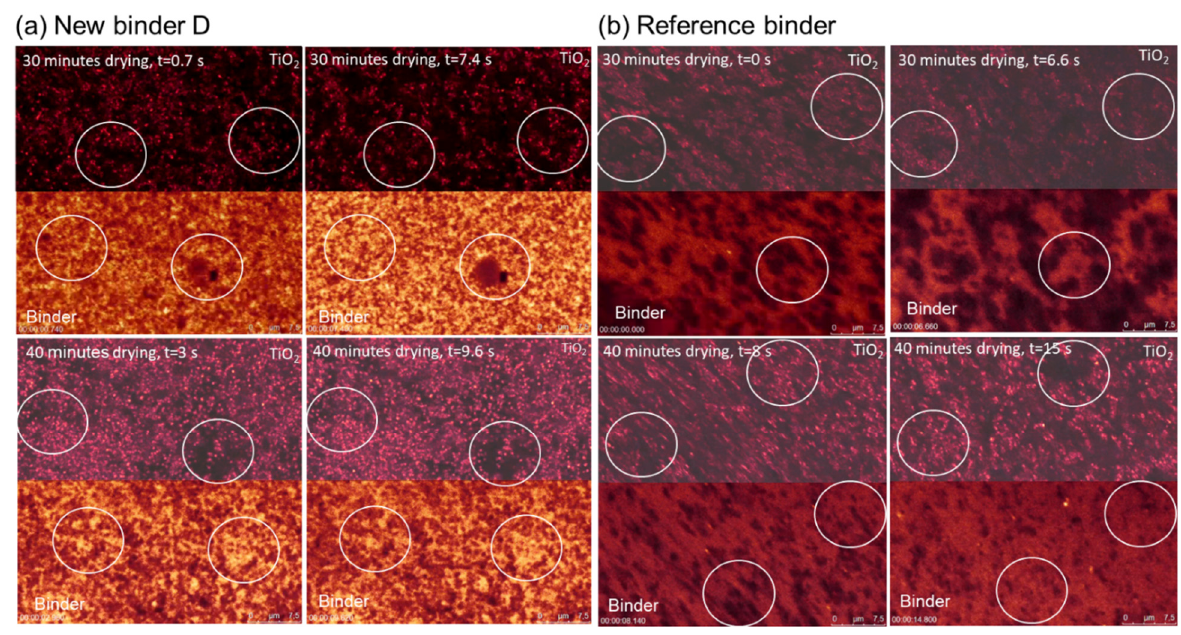
Figure 8. Rewetting kinetics of partially dried paints. If the paint with binder D is followed for a longer exposure time, the result does not change, i.e., no redissolution occurs. Circles mark the areas where constant or changing binder and TiO 2 particle positions can be observed best.